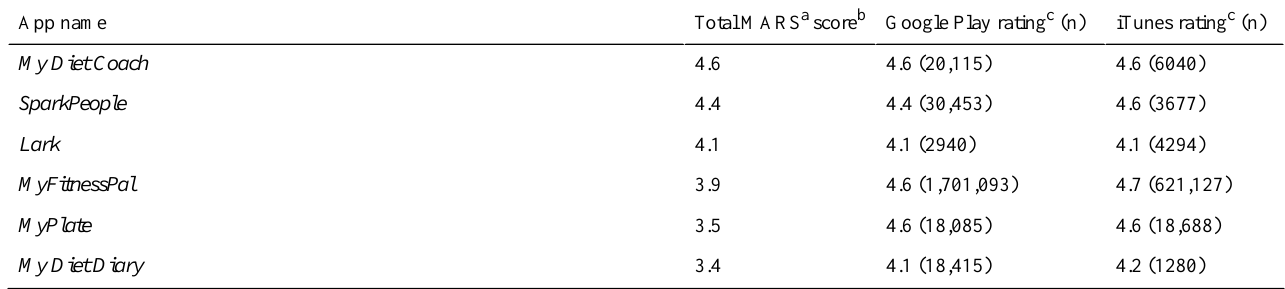
Table 1. List of apps used in the study, sorted by total Mobile App Rating Scale score, with app store